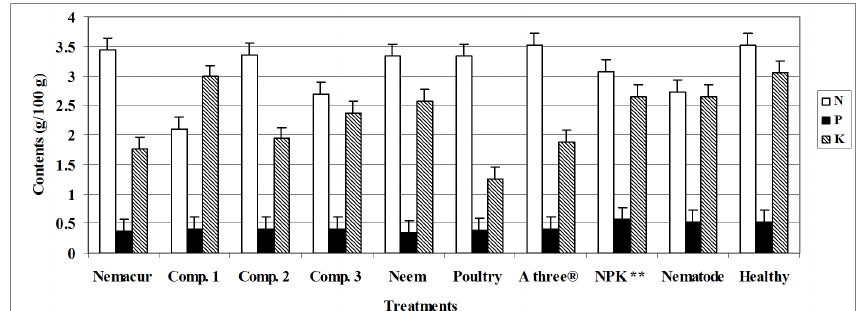
Fig. 3. Tomato shoots contents of N P K affected by M. incognita infection and the application of organic and inorganic fertilizers. Treatments dose (g/pot): Nemacur (10%G): 0.2; Comp. (Compost) 1, 2, 3: 5 g/pot; Neem (dry leaves): 5 g/pot; Poultry (drop- pings): 5 g/pot; A three® (three types of compost): 2 g/pot; N P K** (recommended dose); Nematode: Nematode only; Healthy: Untreated